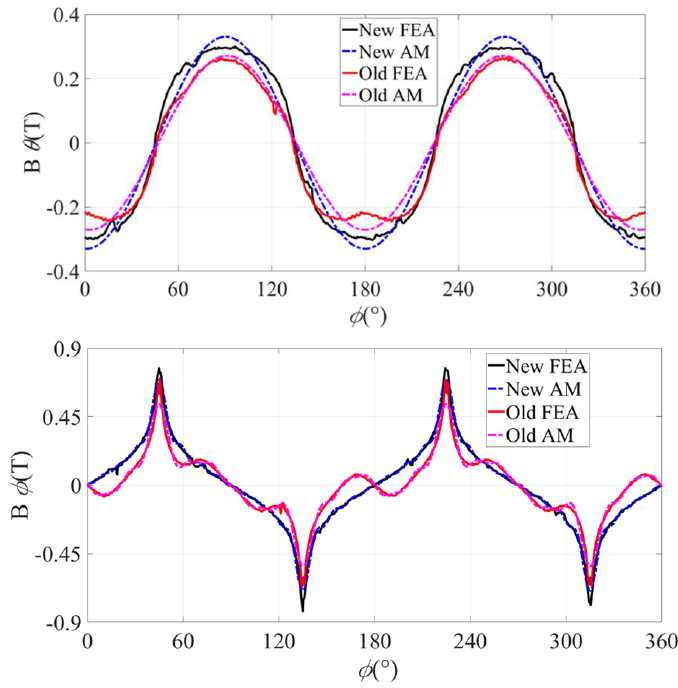
Figure 11. Comparison of three magnetic densities.